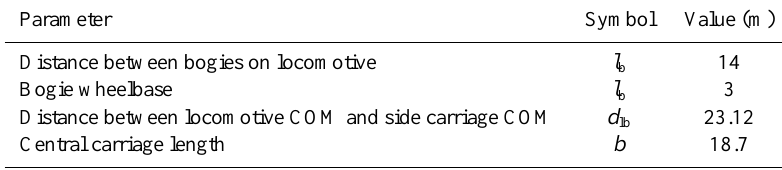
Table 2. Geometric parameters of Thalys HST.